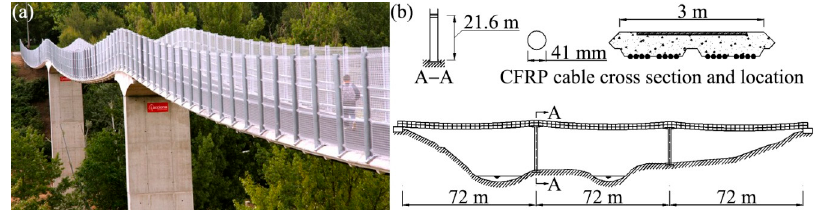
Figure 27. Cuenca Stress-Ribbon Footbridge, ( a ) photo (photo credit: Juan Rodado Lopez) and ( b ) sketch.